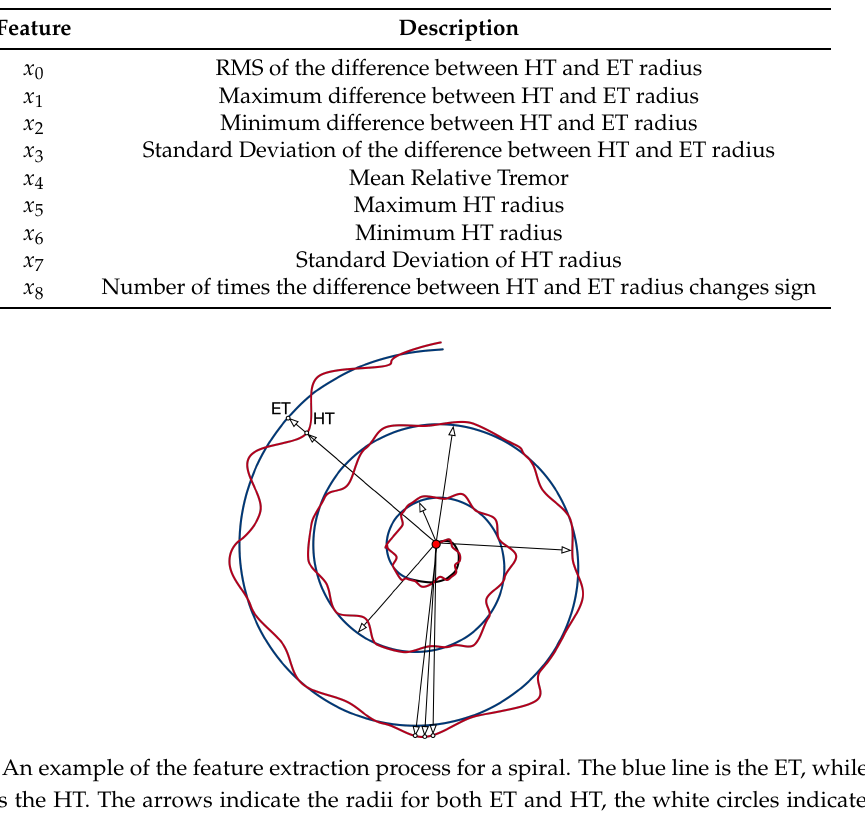
Table 1. Features description of the dataset used. HT: handwritten trace, ET: exam template.